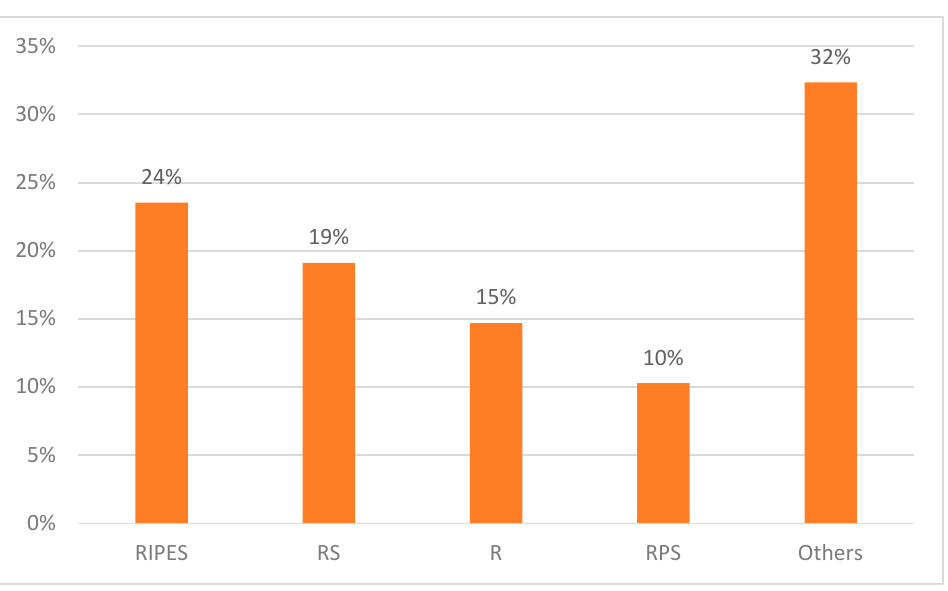
Figure 2. Percentage of CPs and PMVs who reported stocking different loose anti-TB drugs, n = 68.